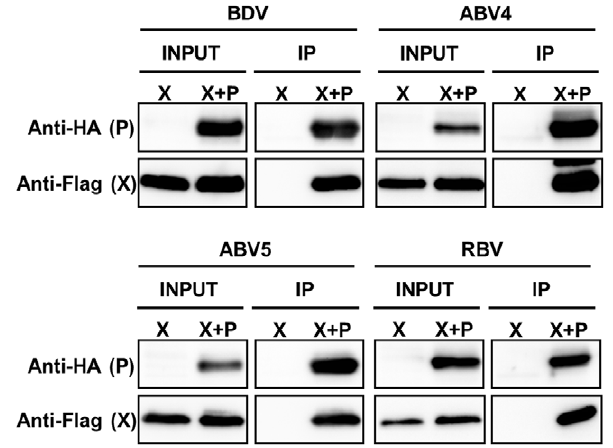
Figure 5. Intra-genotypic interaction between the X and P proteins of bornaviruses. Plasmids expressing the X and P proteins of each bornavirus genotype were co-transfected into 293T cells and interaction between X and P was detected by immunoprecipitation using anti-HA antibody. Immunoprecipitation of X was detected by anti-Flag